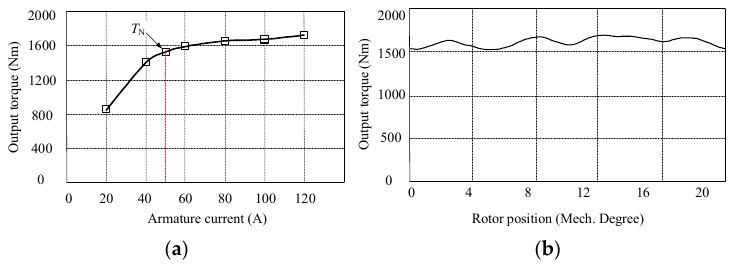
Figure 13. Electromagnetic torque ( T N is the rated torque): ( a ) electromagnetic torque variation with armature current and ( b ) rated electromagnetic torque.